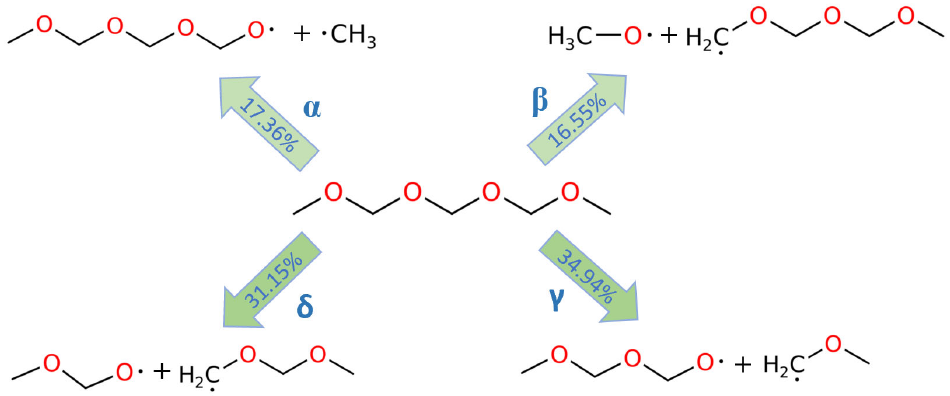
Figure 2. C ‐ O bond dissociation in PODE3 at 3000 K. Figure 2. C-O bond dissociation in PODE3 at 3000 K.